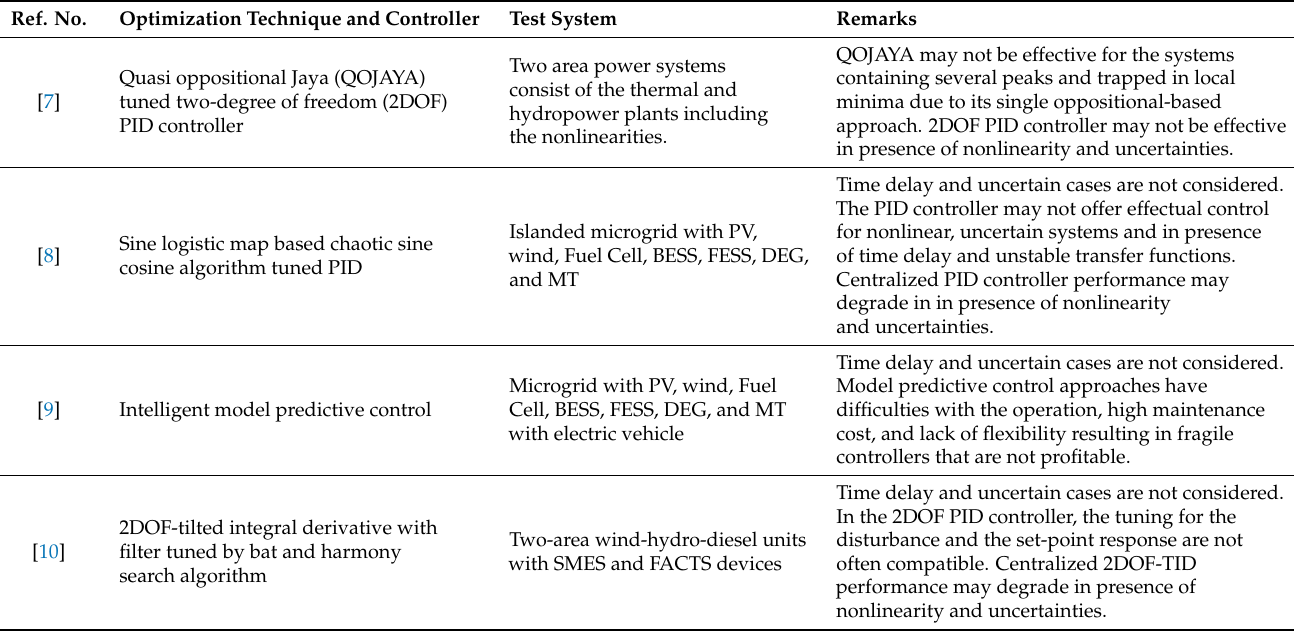
Table 1. Comparative analysis of various frequency control approaches in different test